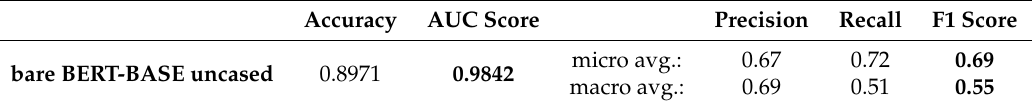
Table 13. Bare BERT-base uncased model performance after the